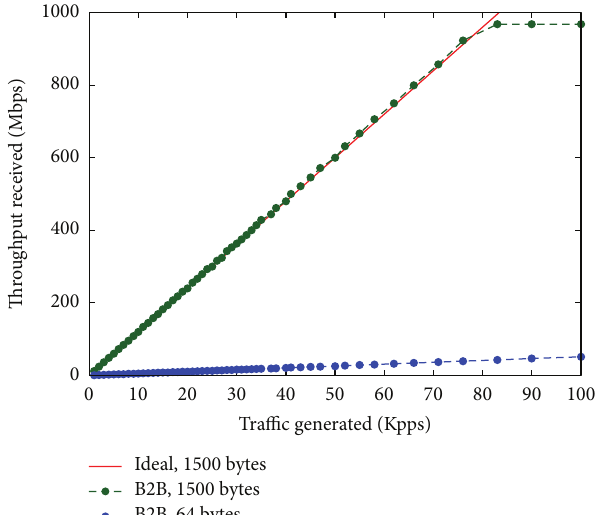
Figure 10: Received versus generated packet rate in the OpenStack scenario setups (1.1) and (1.2), with 1500 -byte